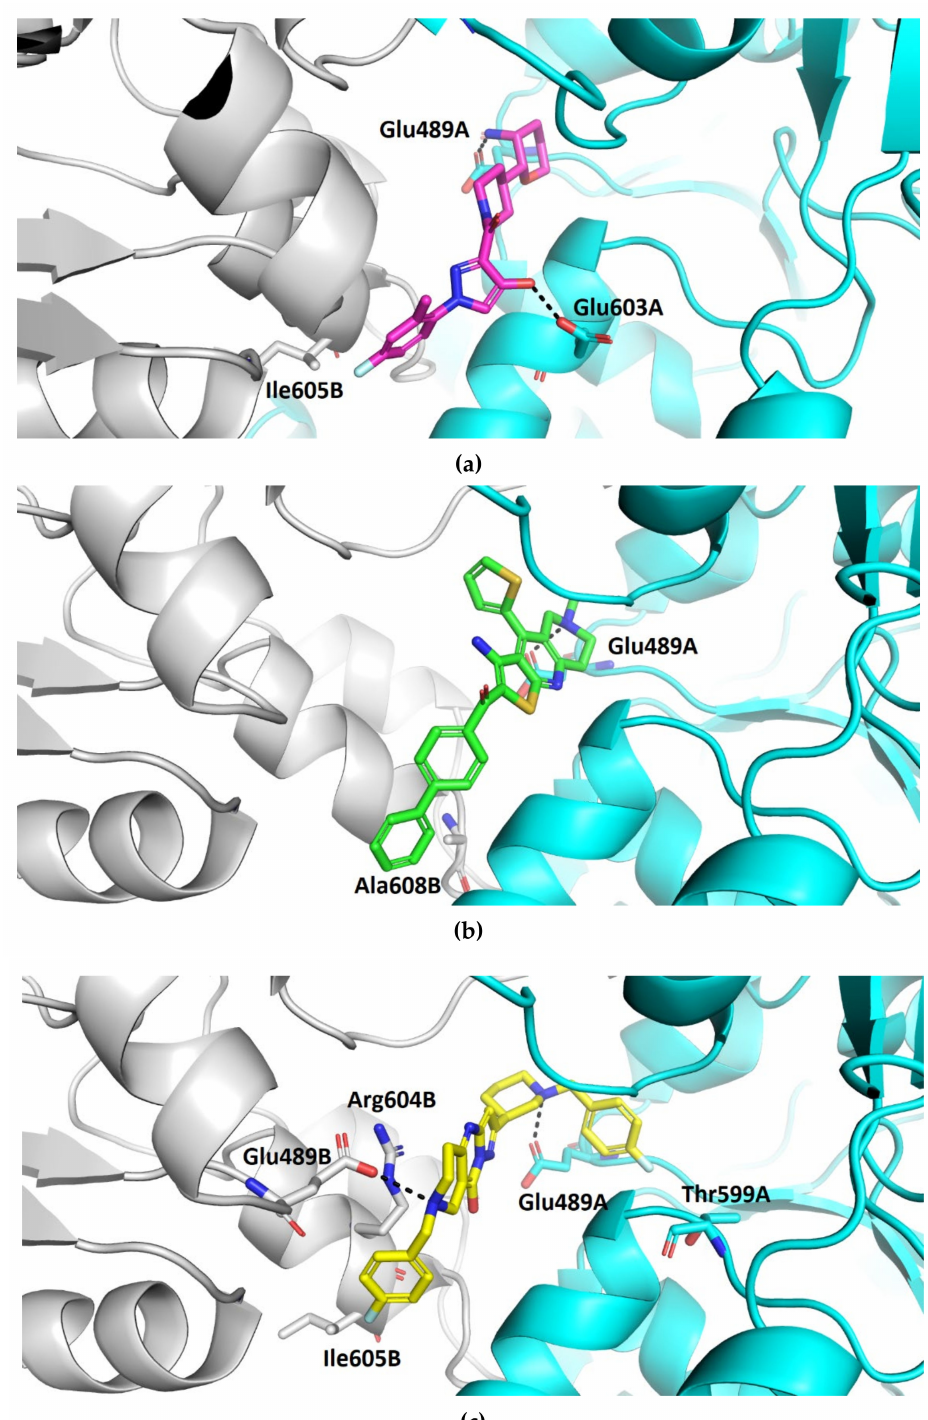
Figure 3. Binding modes of ( a ) TVS-22 (in magenta sticks), ( b ) TVS-23 (in green sticks) and ( c ) TVS-24 (in yellow sticks) in the C-terminal domain binding site of Hsp90 β dimer (protomers A and B are coloured cyan and grey, respectively). For clarity, only amino acids forming hydrogen bonds (black dashed lines), cation- π and hydrophobic interactions with inhibitors are shown as